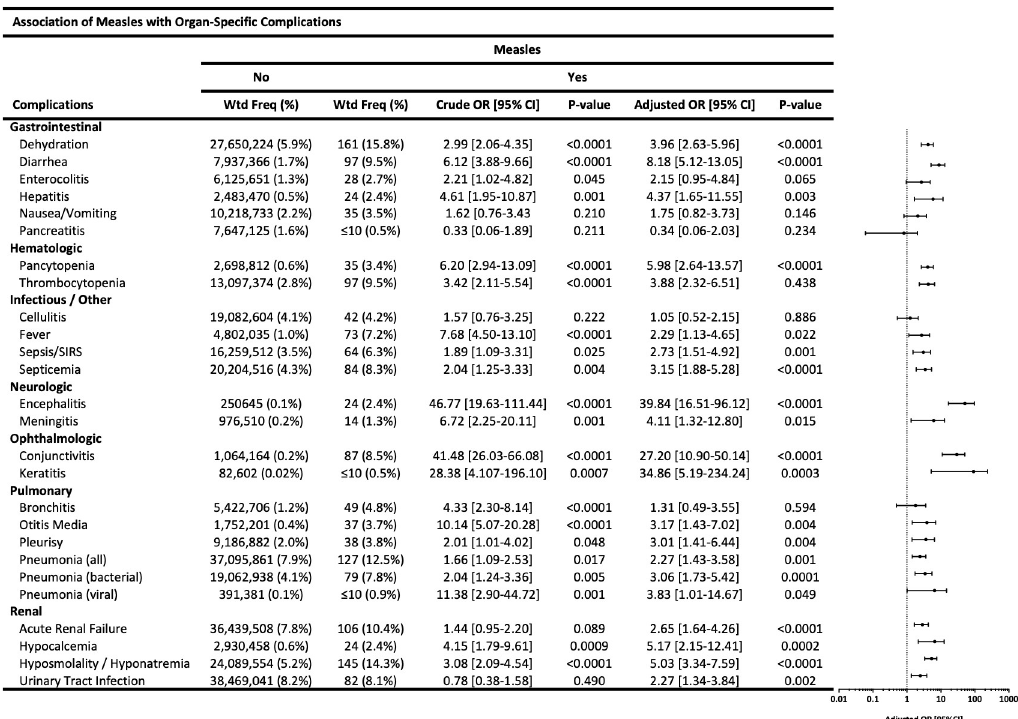
Fig 2. Association of measles with organ-specific complications. Frequencies and multivariable logistic regression models showing association of measles with gastrointestinal, hematologic, infectious, neurologic, ophthalmologic, pulmonary, and renal